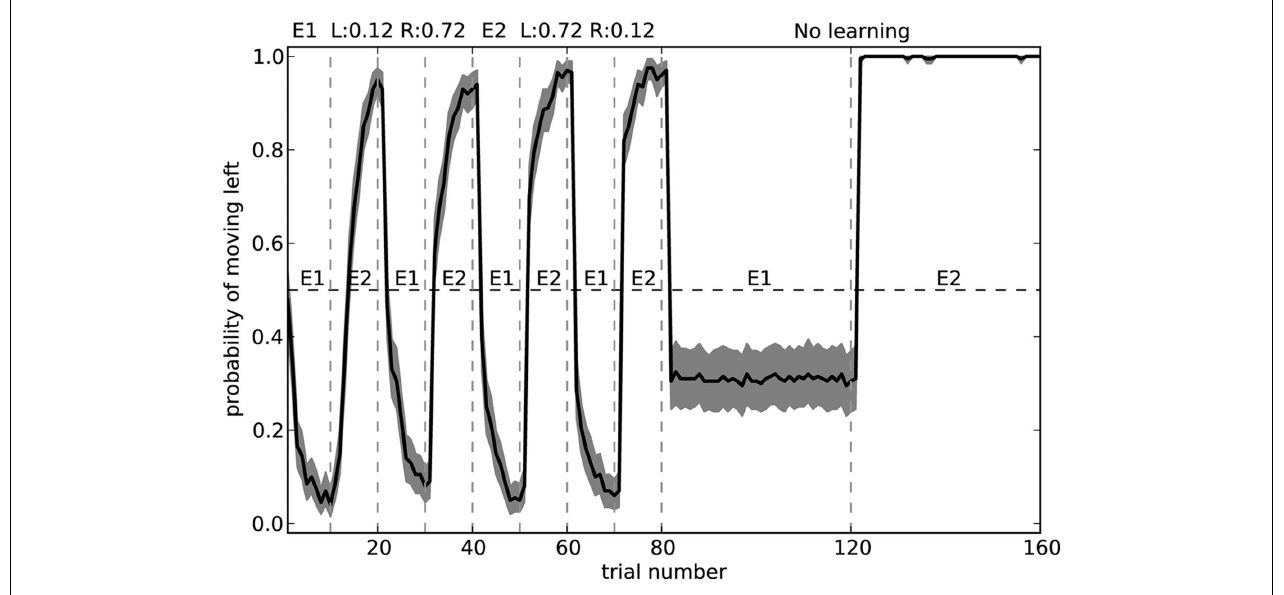
FIGURE 12 | Model performance when learning is turned off after the first 80 trials. During learning, the environment is swapped every 10 trials, rather than every 40 as in Figure 11 . Shaded area shows 95% bootstrap confidence intervals over 200 runs. A different randomly chosen state vector is used for each of the two